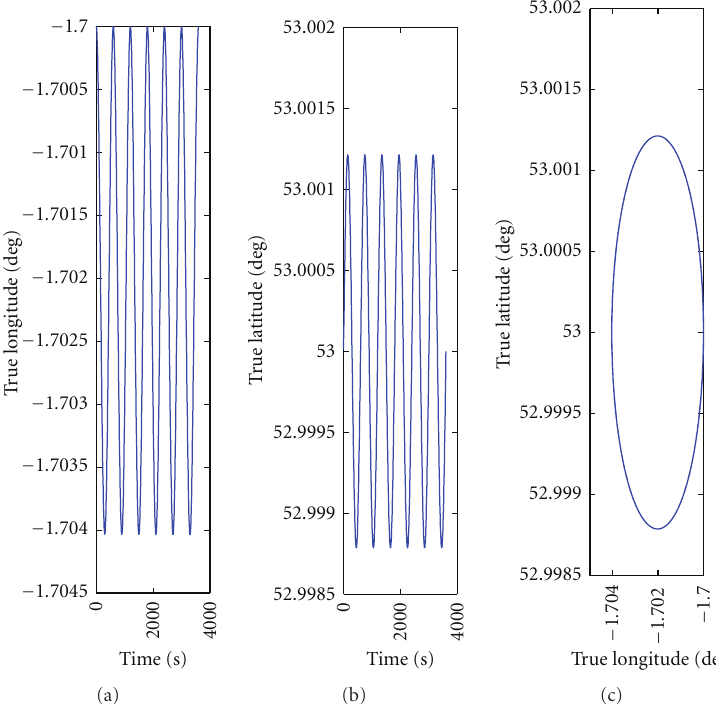
Figure 15: The designed trajectory of circle simulation.